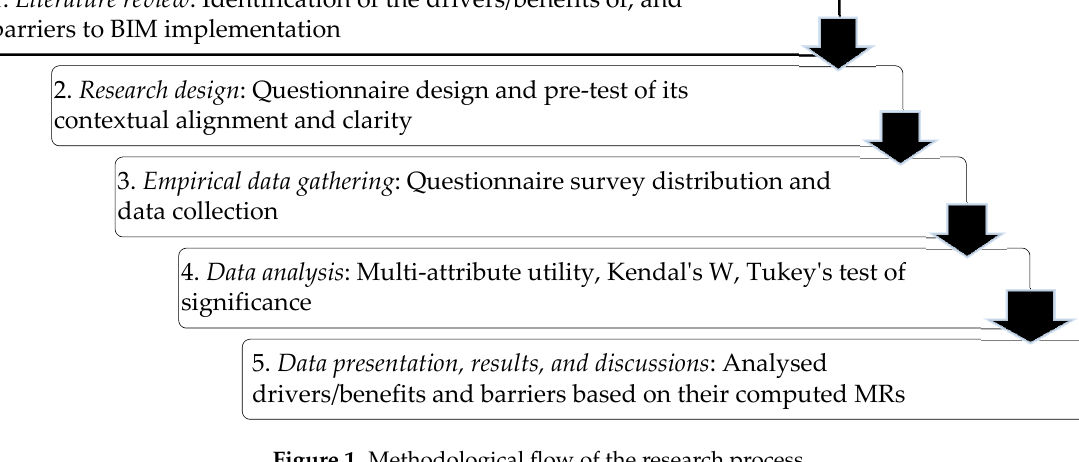
Figure 1. Methodological flow of the research process.